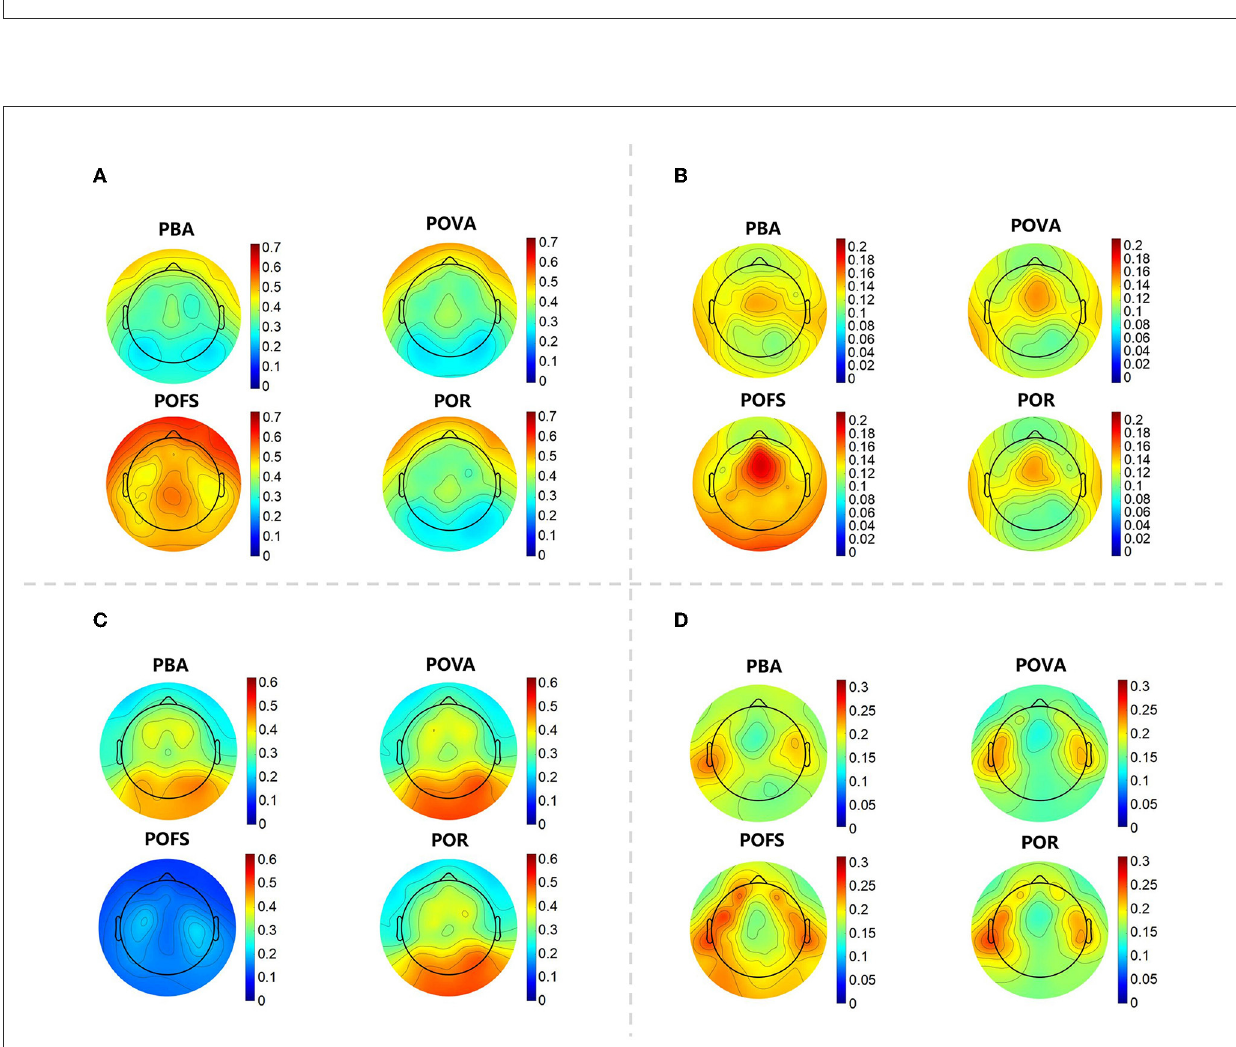
FIGURE2 The topographic map of each EEG rhythm in each phase. (A) The topographic map of the relative power of the delta rhythm in the four phases. (B) The topographic map of the relative power of the theta rhythm in the four phases. (C) The topographic map of the relative power of the alpha rhythm in the four phases. (D) The topographic map of the relative power of the beta rhythm in the four